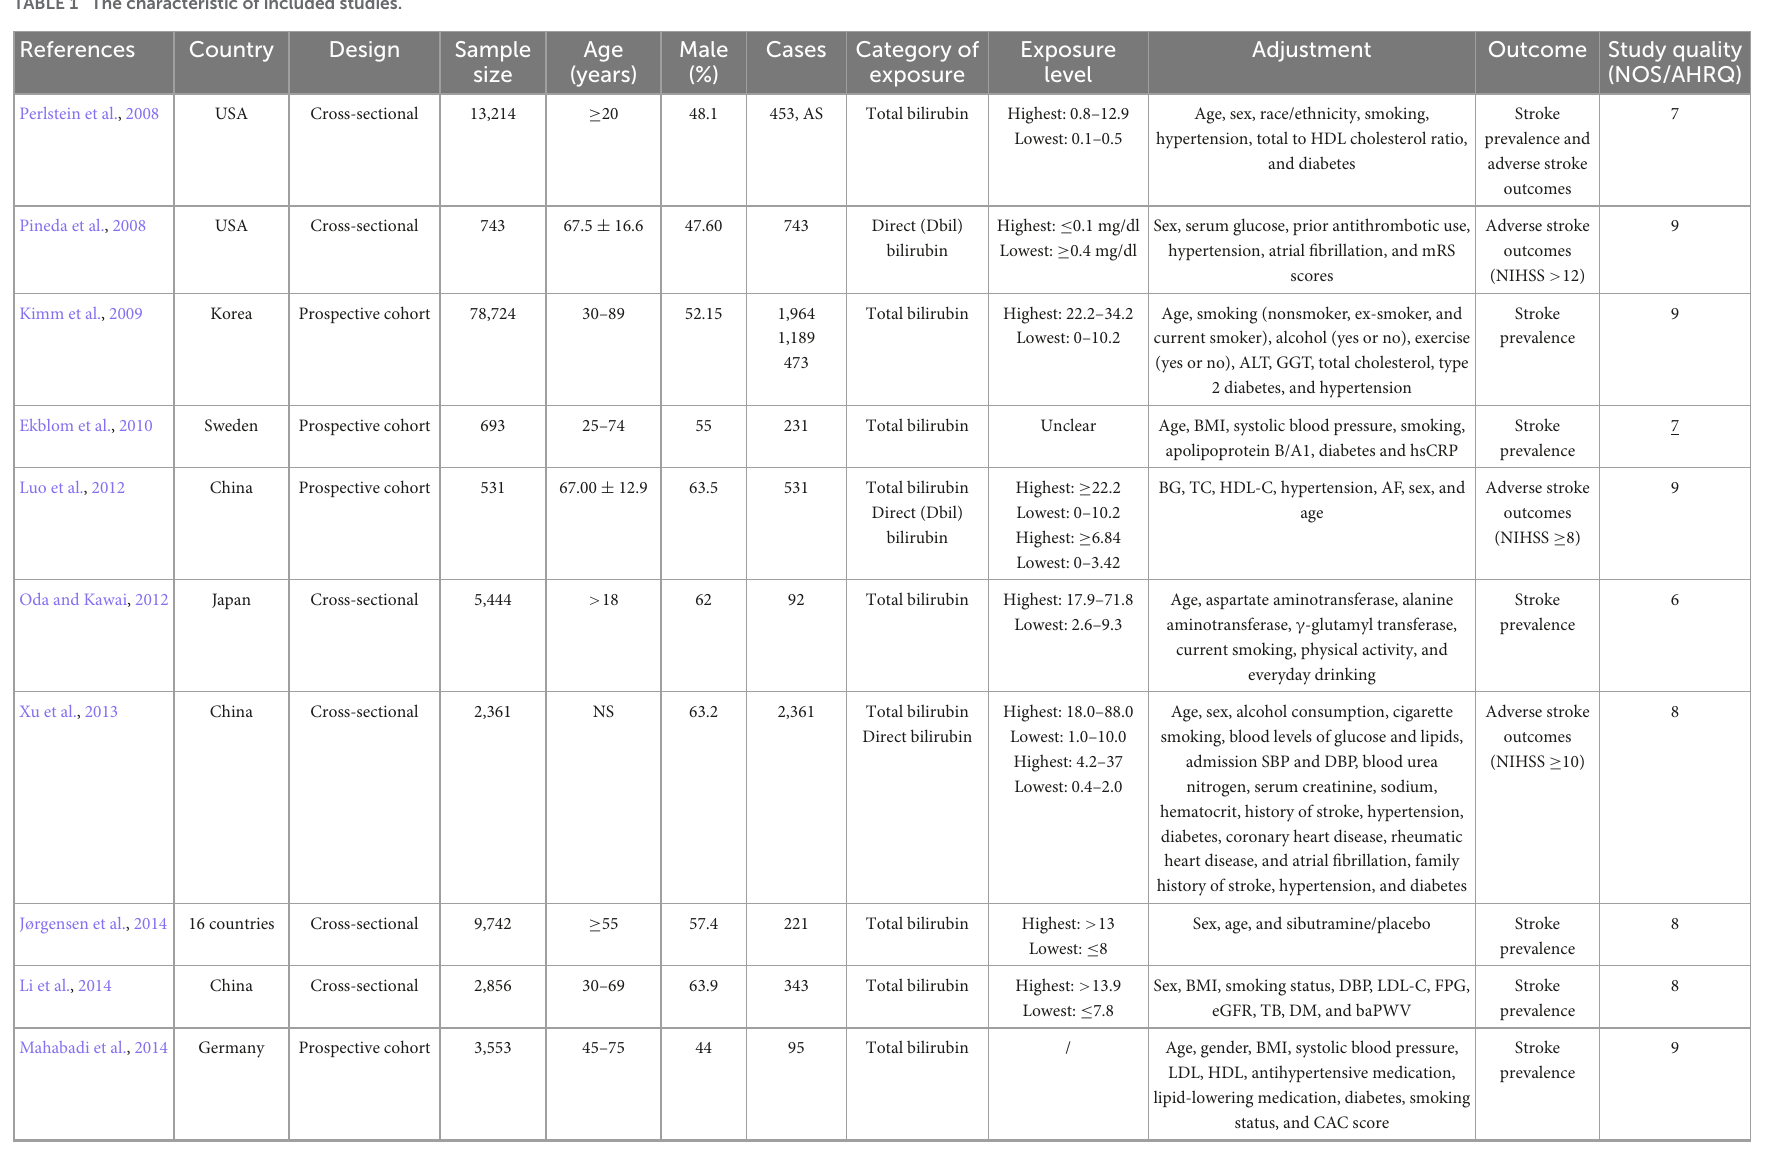
TABLE 1 The characteristic of included